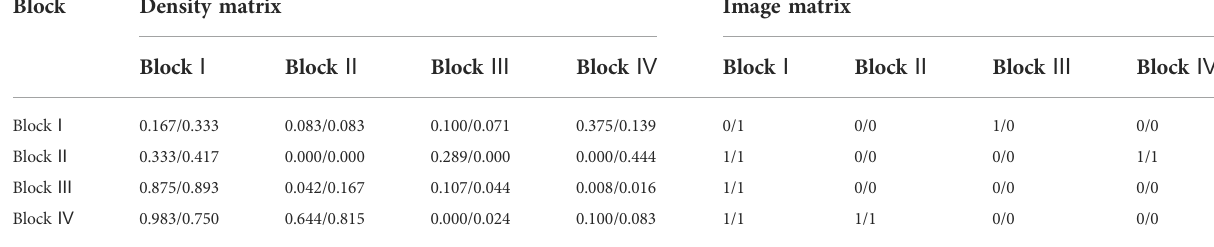
TABLE 7 The density matrix and image matrix of spatial association network of GIE in China.